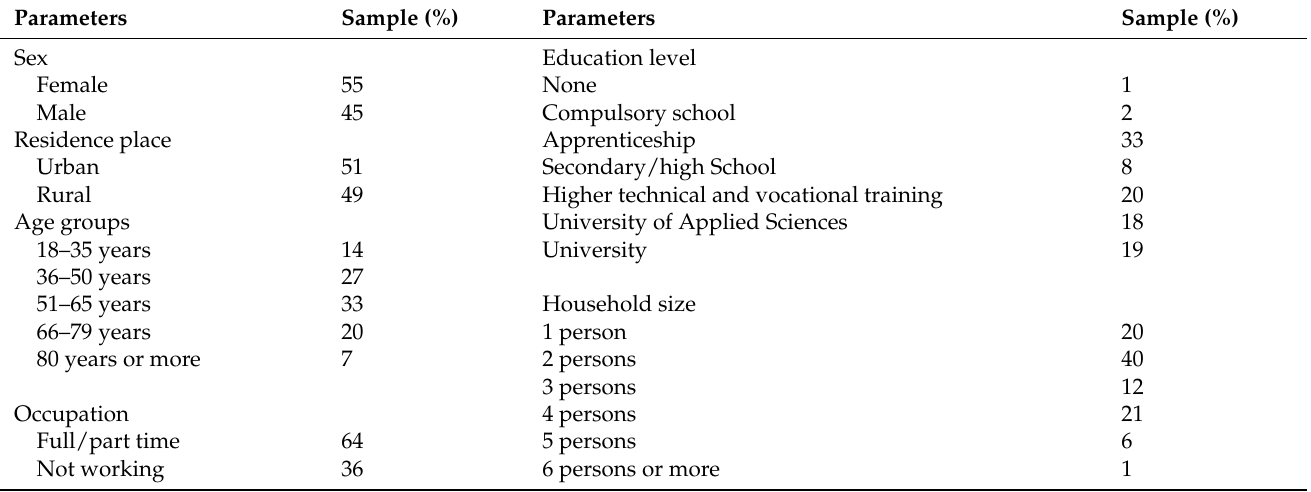
Table 1. Characteristics of the studied sample ( n =